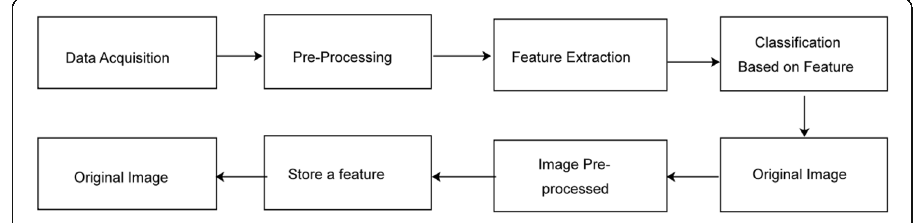
Fig. 1 Flow chart of data